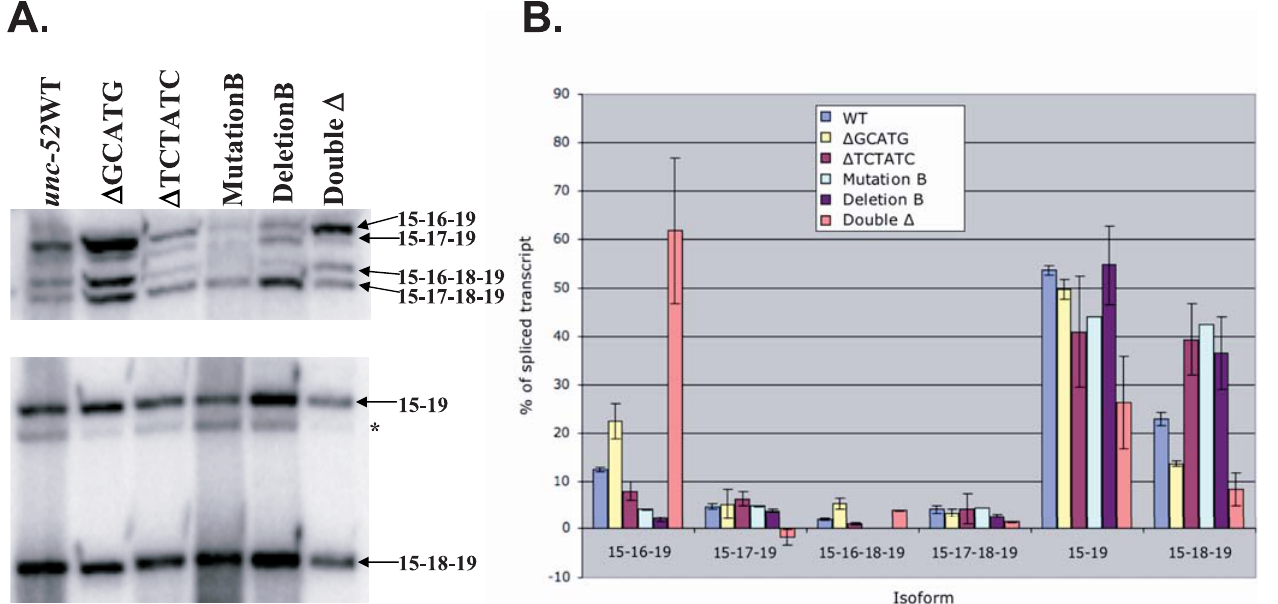
Figure 4. Deletion or Mutation of Top Scoring Pentamers or Hexamers Alters unc-52 Alternative Splicing (A) Autoradiogram of unc-52 reporter gene alternative splicing. Left side shows 32 P RT-PCR analysis (with BamHI digest) performed on strains carrying each of the reporter constructs described in Figure 3B. The reporter is indicated at top of gel. Table on right shows the relative percentage of each alternatively spliced isoform produced from the indicated in vivo splicing reporter constructs. Arrows point to the corresponding band on the gel. Asterisk denotes a non-specific band resulting from RT-PCR. (B) Graphical summary of unc-52 in vivo splicing reporter assays. Horizontal axis indicates spliced mRNA isoform. Vertical axis represents the relative percentage of each isoform. Color key on figure indicates which bars correspond to which strain. Standard deviation and mean values were calculated based on a minimum of three independent RNA extractions and subsequent RT-PCRs for each reporter. DOI: 10.1371/journal.pcbi.0020086.g004